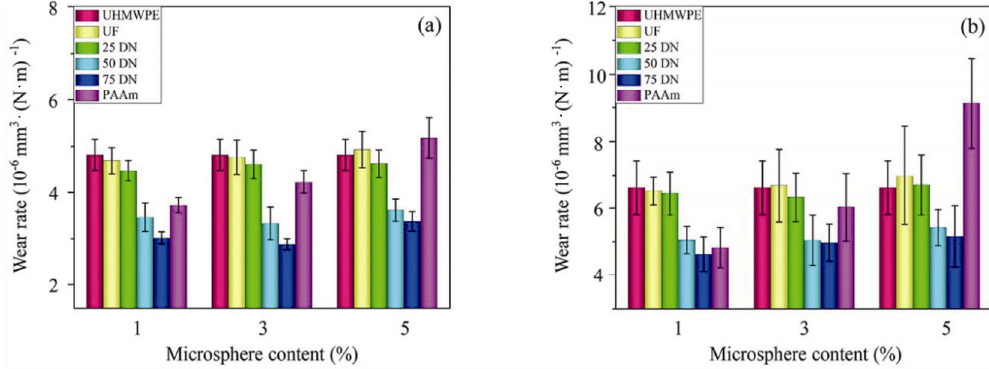
Fig. 8 Wear rate of polymer discs under different applied loads: (a) 5 N and (b) 10 N.